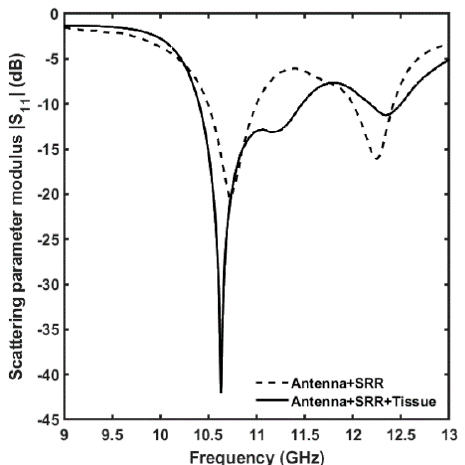
Figure 10. Measured scattering parameter modulus | S 11 | versus frequency of SIW cavity-backed patch antenna with metamaterial lens, that irradiates in biological tissue (continuous line) and in air (dashed line).